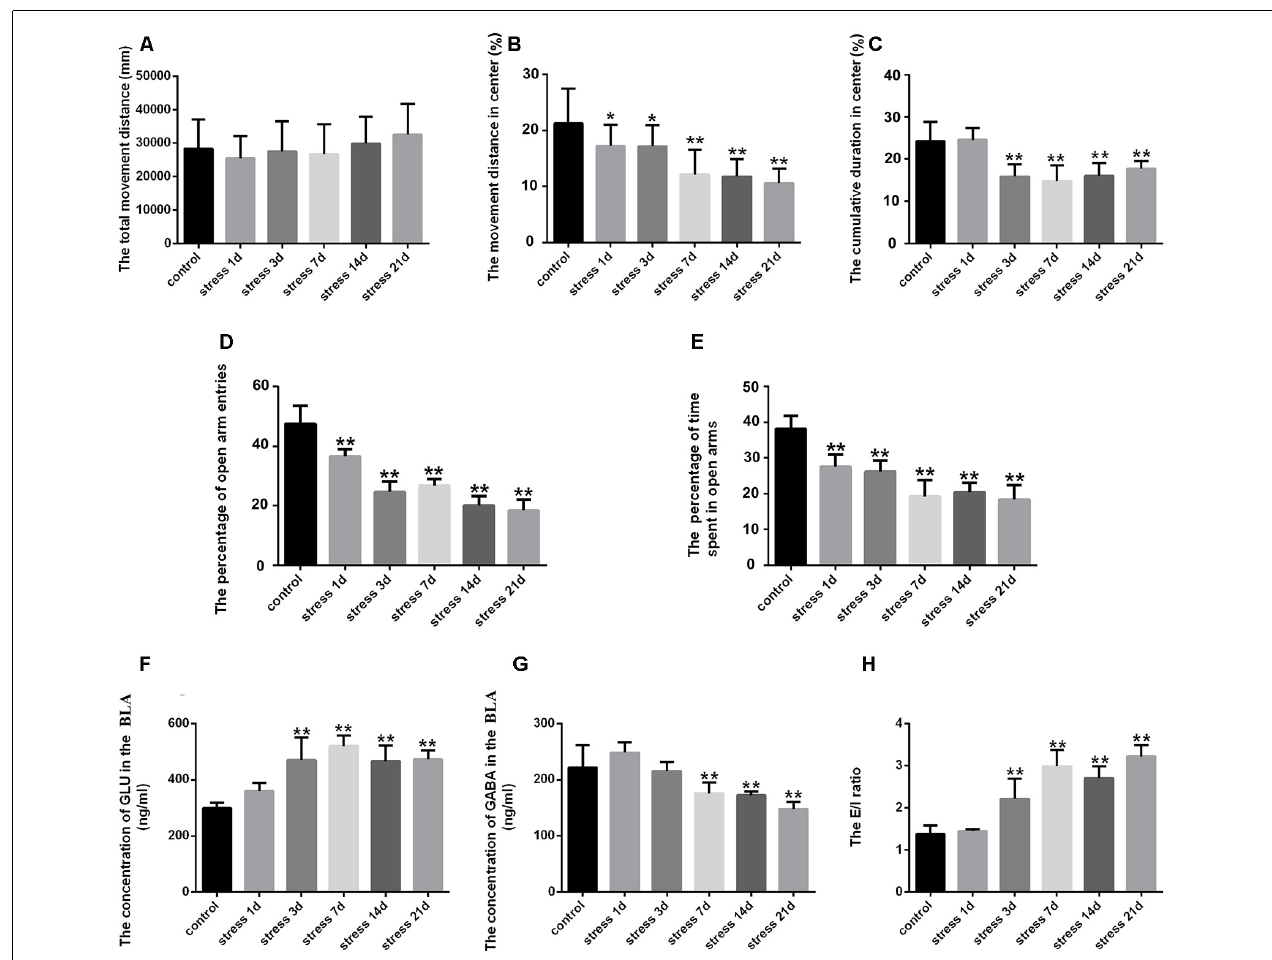
FIGURE 1 | Stress caused anxiety-like behavior and neurotransmitter level changes in the amygdala of rats. (A) Total movement distance on the open field test. (B) Percentage of movement distance in the center area of the open field test. (C) Percentage of cumulative duration in the center area of the open field test. (D) Percentage of open arm entries on the elevated plus-maze (EPM). (E) Percentage of time spent in open arms of the EPM. (F) The concentration of GLU in the amygdala. (G) The concentration of γ -aminobutyric acid (GABA) in the amygdala. (H) The excitation/inhibition (E/I) ratio. Data (mean ± SEM) represent. ∗ P < 0.05, ∗∗ P < 0.01 vs. control group ( n =